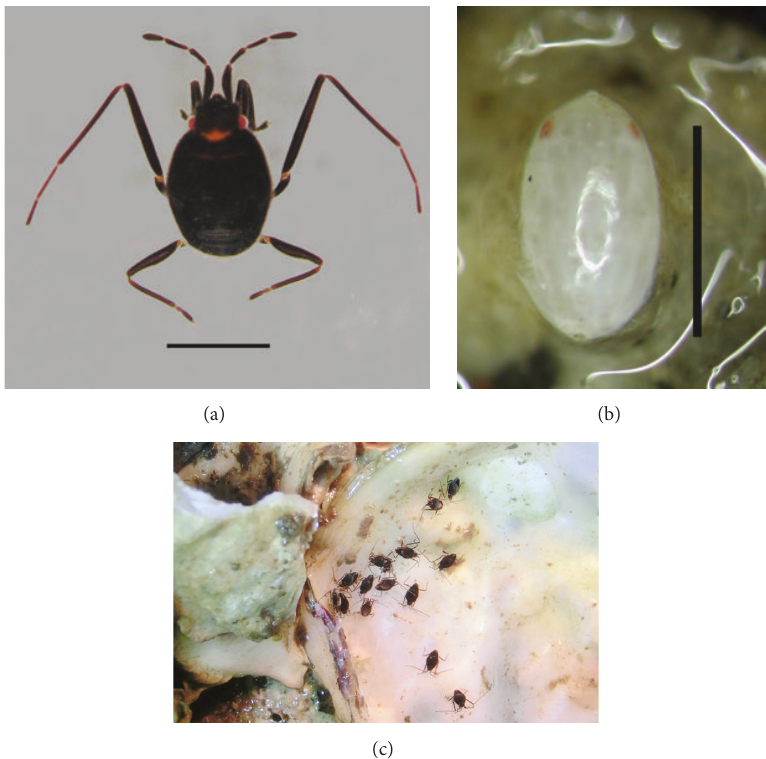
Figure 1: H. septentrionalis . (a) Male adult. Scale = 1mm (Photo by T. Ikawa). (b) Developing egg with red eye-spots showing through. Scale = 0.5 mm (Photo by T. Ikawa). (c) Overwintering individuals in an oyster shell (Photo by H. Era).